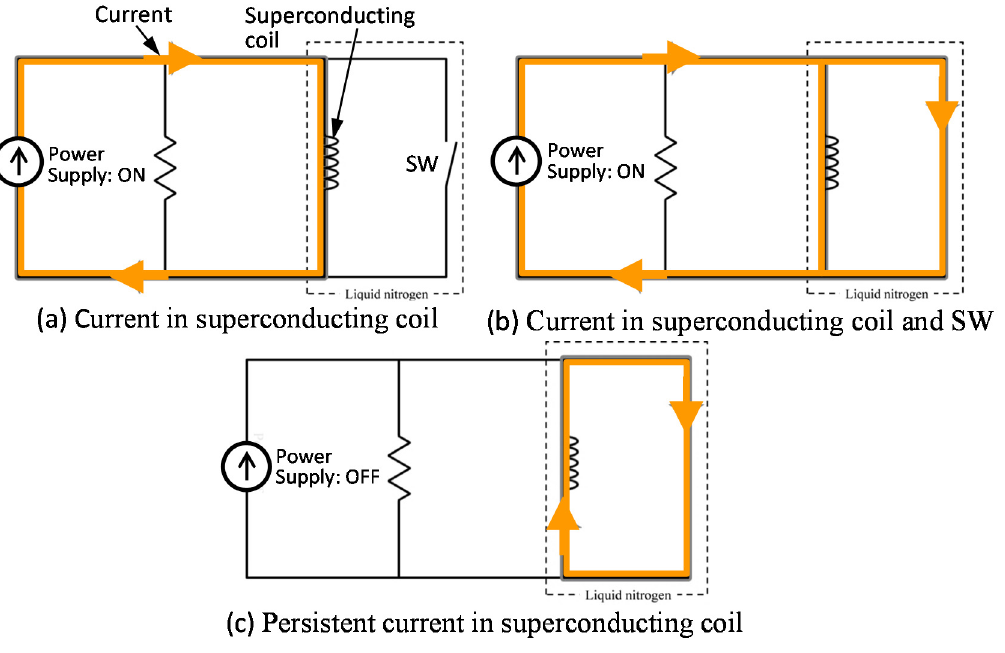
Figure 3. Electric circuit for persistent current mode.